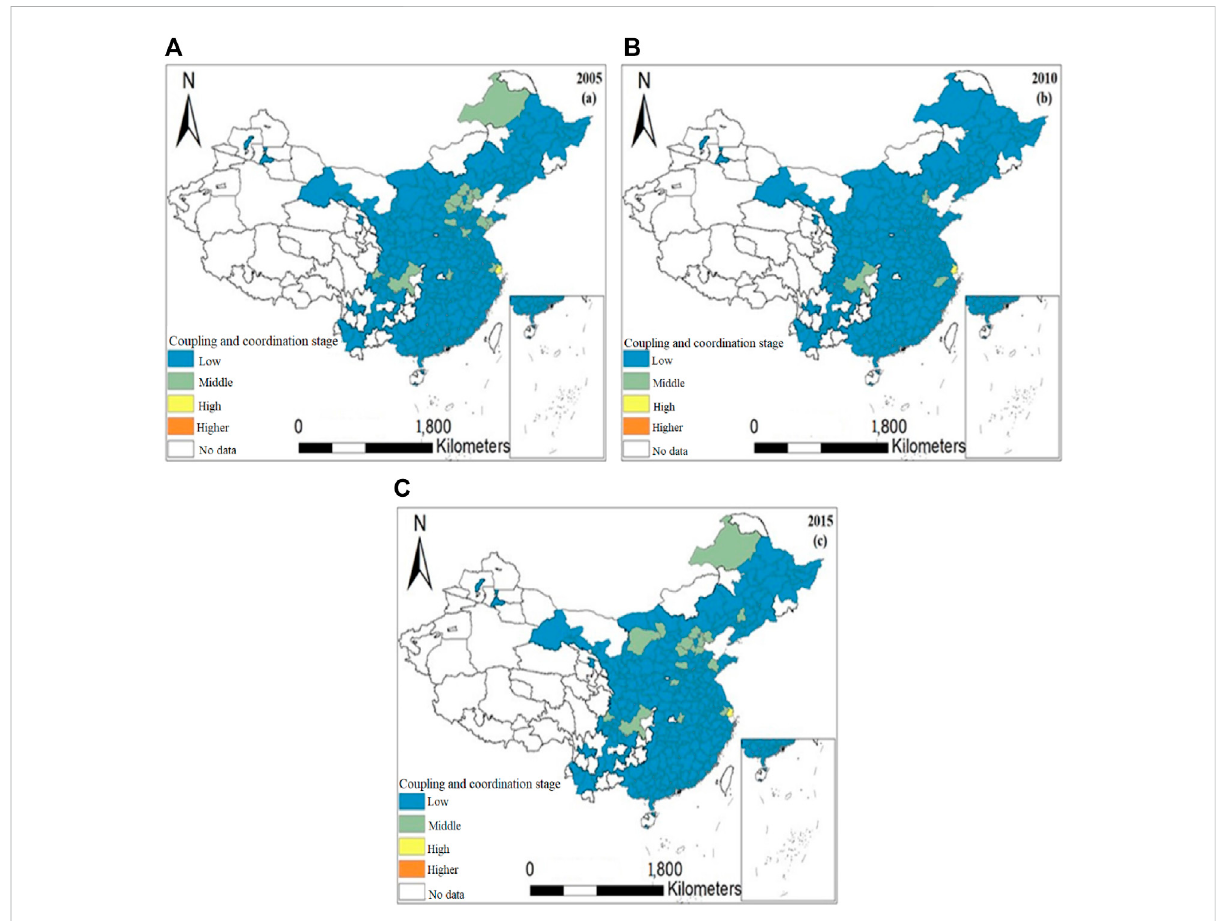
FIGURE 3 Spatial distribution of the coupling coordination degree; (A) for 2005, (B) for 2010, (C) for 2015.